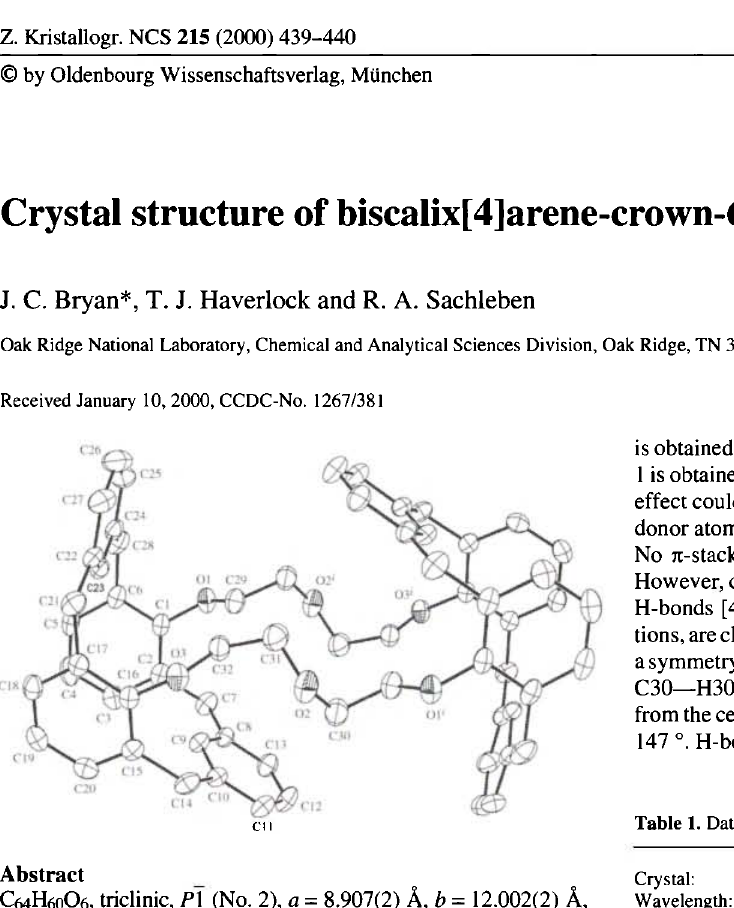
Table 1. Data collection and handling.